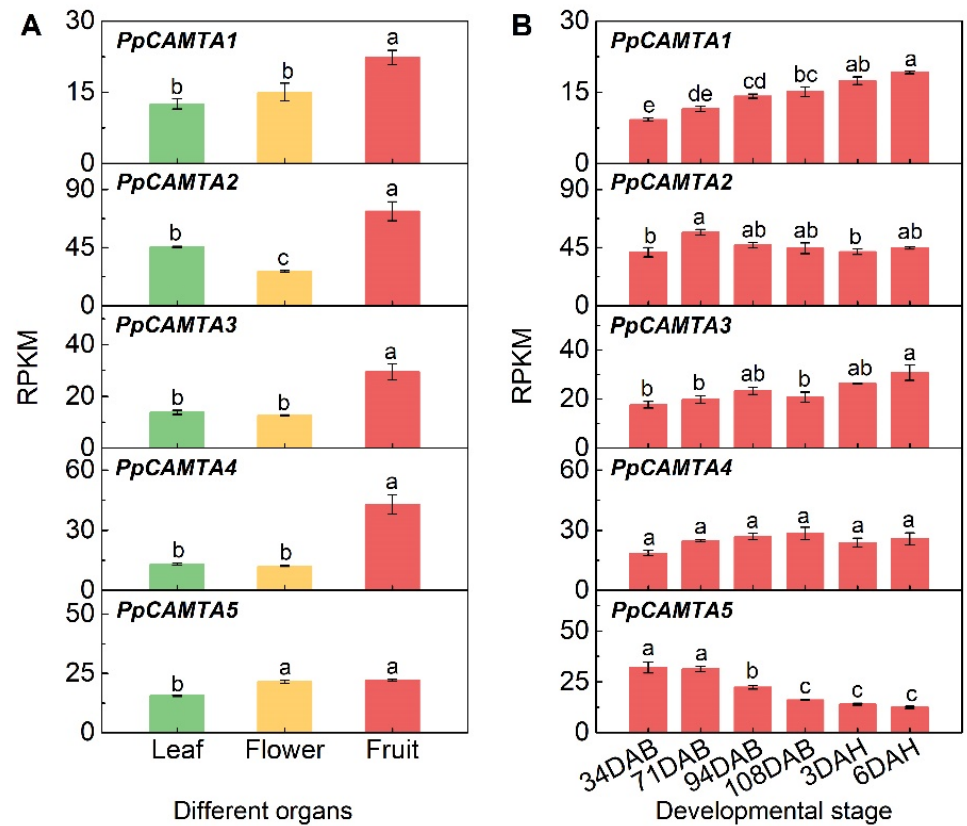
Figure 5. Expression of peach CAMTA genes in different organs and during fruit different stage. ( A ) Expression pattern of peach CAMTA genes in different organs including leaf (green), flower (yellow), and ripe peach fruit (red). ( B ) Expression pattern of peach CAMTA genes of different stages in peach fruit. Means and standard errors were calculated from three replicates. Different letters above the bars represent significant differences ( p < 0.05).